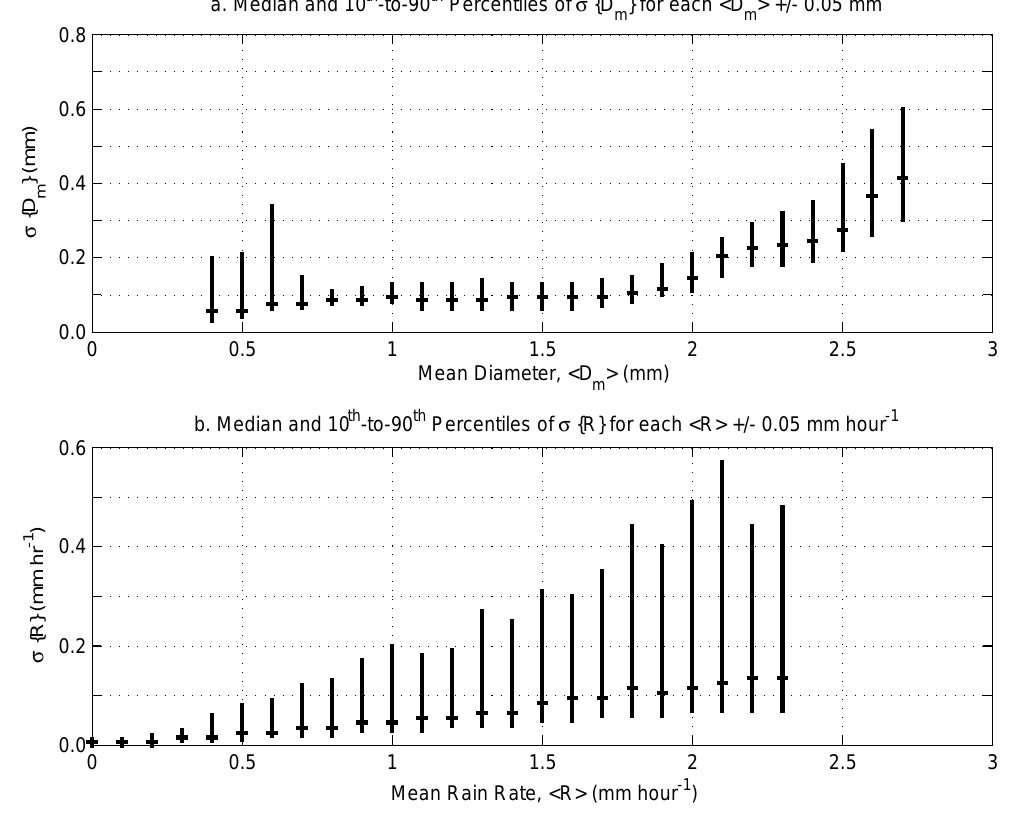
Fig. 8. Panel (a) shows the 10th-to-90th percentile ranges of σ { D m } for 0.1mm intervals of h D m i . The median value for each h D m i interval is shown with a horizontal line. Panel (b) shows the 10th-to-90th percentile ranges of σ { R } for 0.1mmh − 1 intervals of h R i along with the median value shown with a horizontal